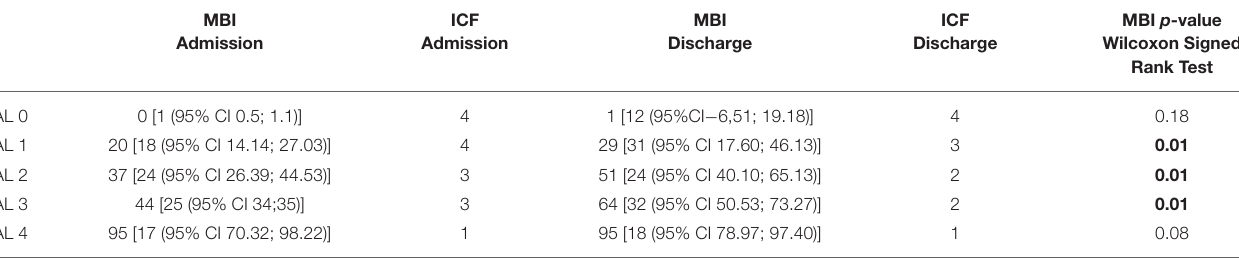
TABLE 9 | Median [IQR (95% CI)] scores of